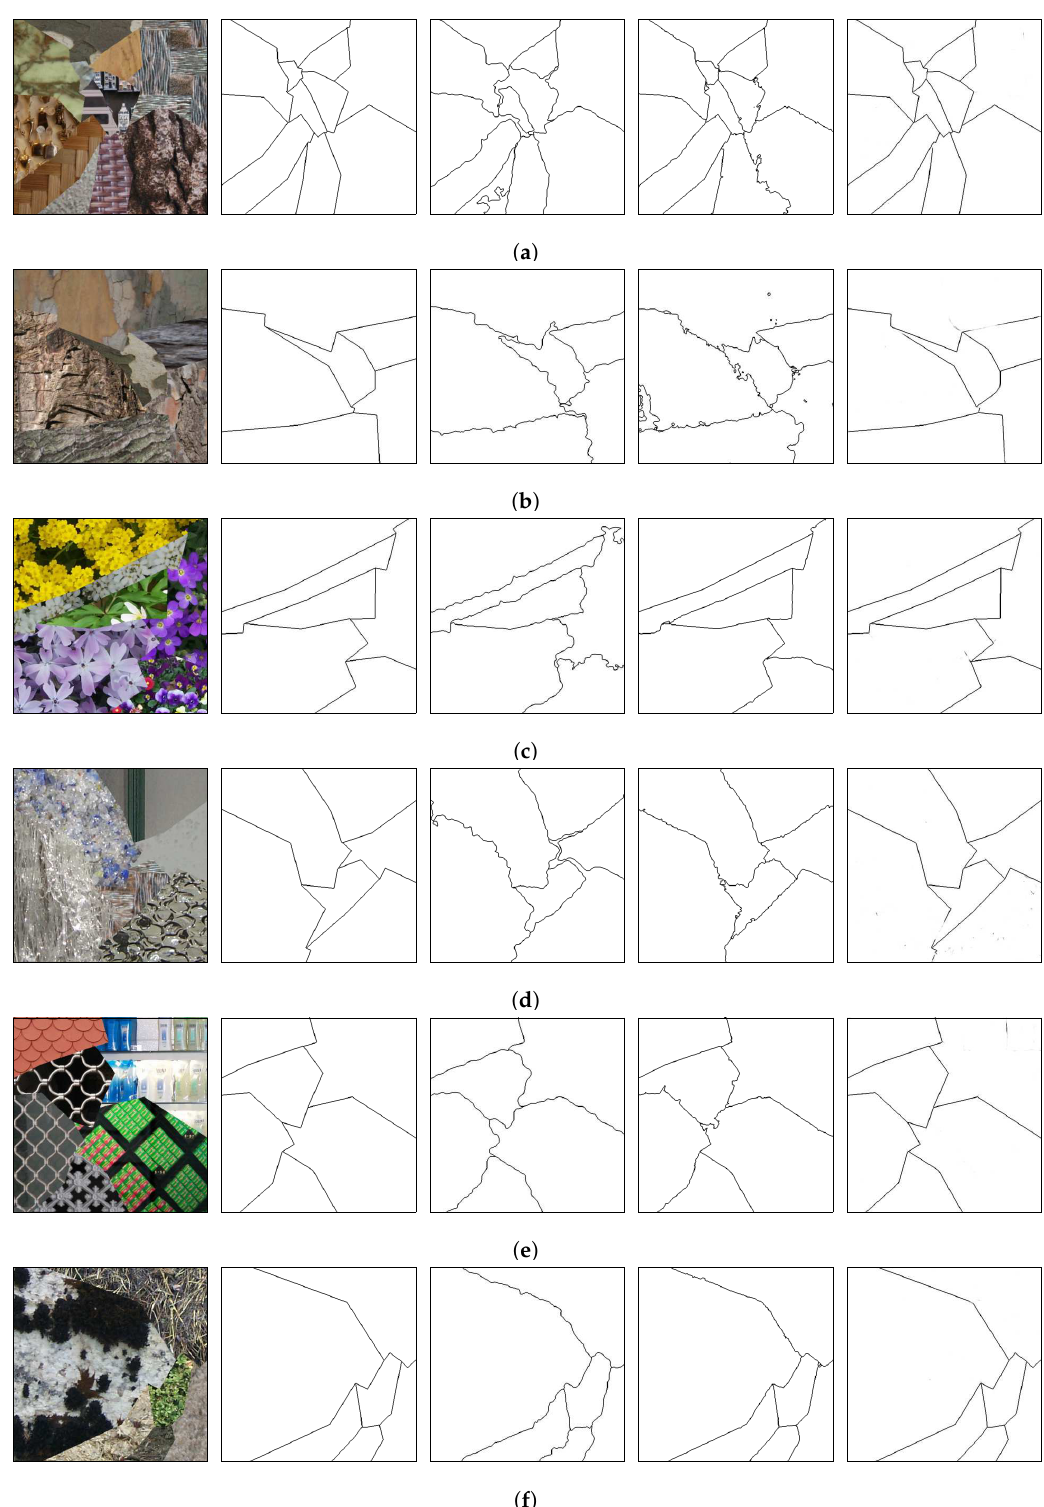
Figure 16. Comparison on the Prague Texture Dataset Generator and Benchmark [70]. From the first to the fifth column, respectively: original images; ground truths; edges produced by the network in [67]; edges produced by the network in [69]; edges produced in the presented method (continuation). Letters ( a – f ) present different benchmark textures mosaics and are used for referencing the images in the